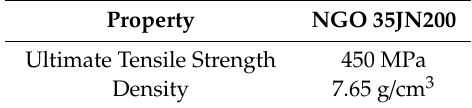
Table 2. Mechanical properties of NGO 35JN200 electrical